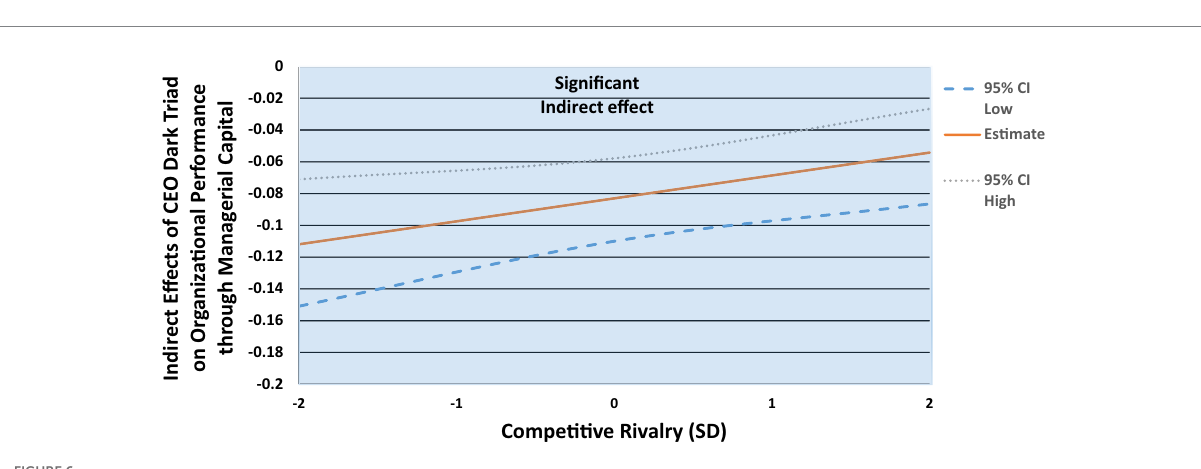
FIGURE 6 Indirect effects of CEO dark triad on organizational performance through managerial capital, conditional on competitive